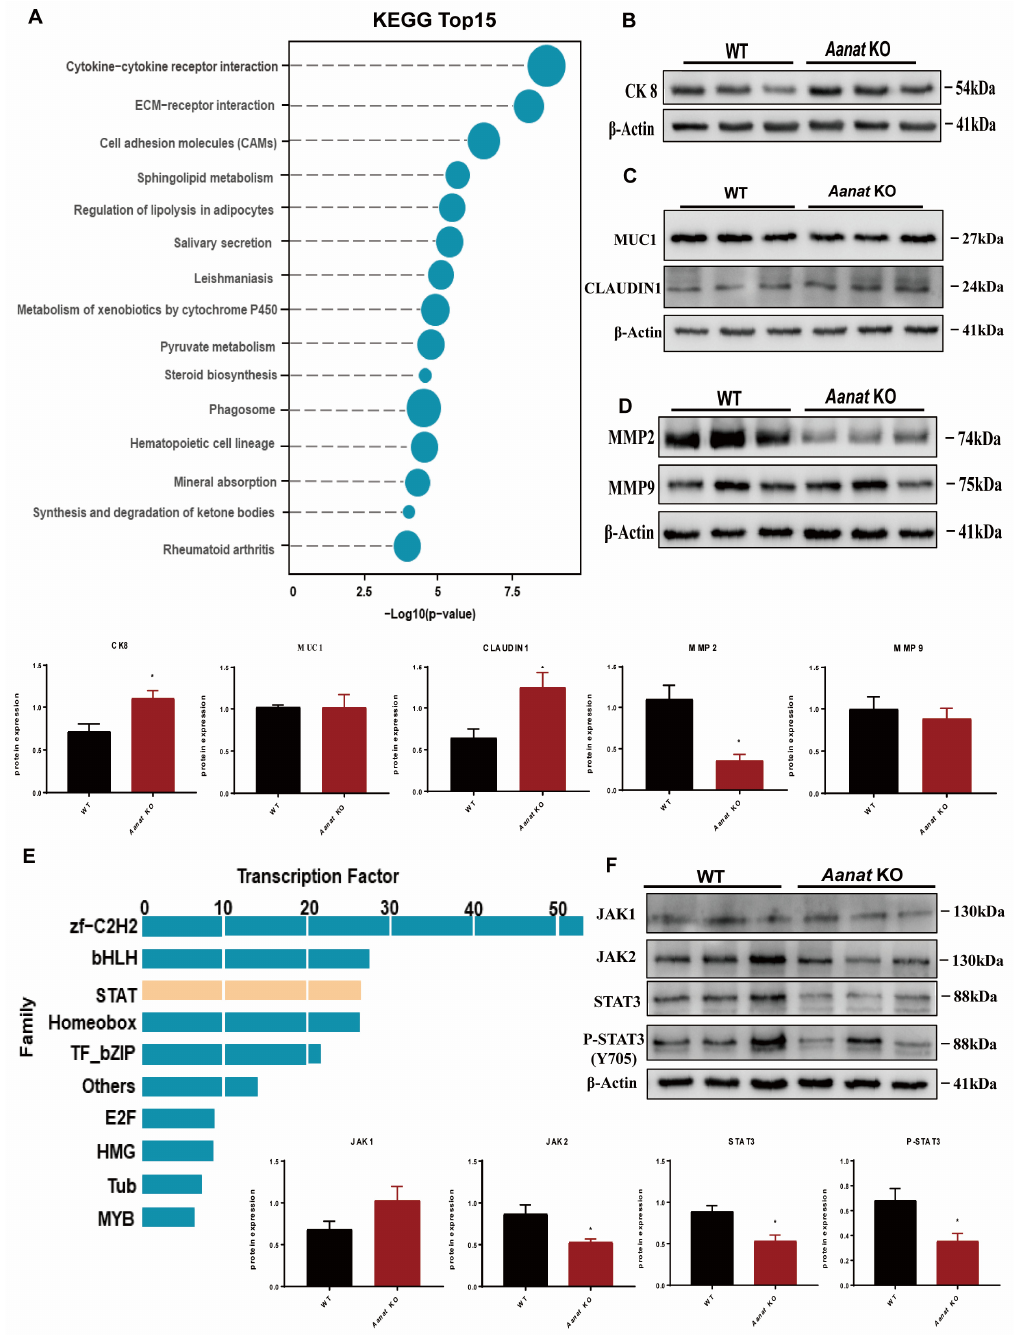
Figure 3. Effects of Aanat KO on the essential pathways of uterine implantation in the implantation window at 4.5 dpc in mice. ( A ) KEGG cluster analysis. ( B – D ) Western blotting of ECM, CK8, MMP2, MMP9, MUC1, and CLDN1, respectively, with statistical analyses. ( E ) Transcription factor differential analysis. ( F ) Western blotting of JAK–STAT with statistical analysis, n = 3. Note: * p <